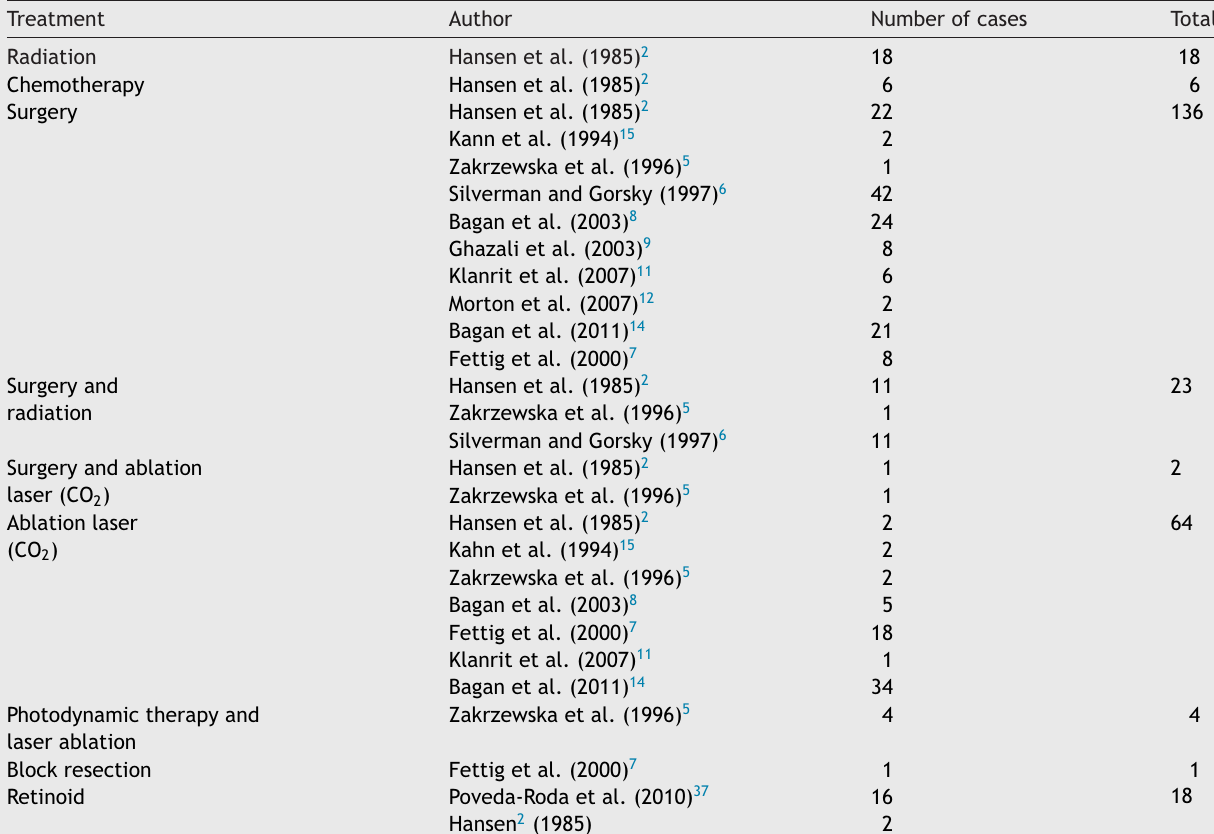
Treatments applied in cases series from